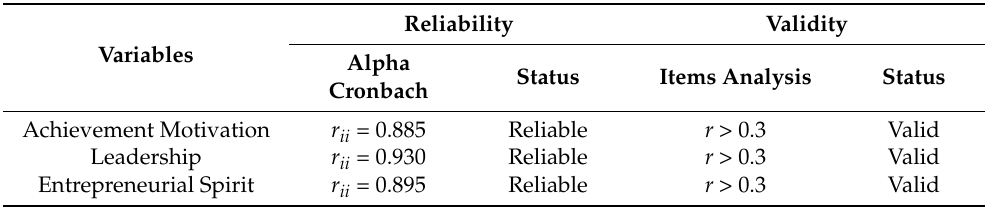
Table 2. The results of the reliability and validity analysis.